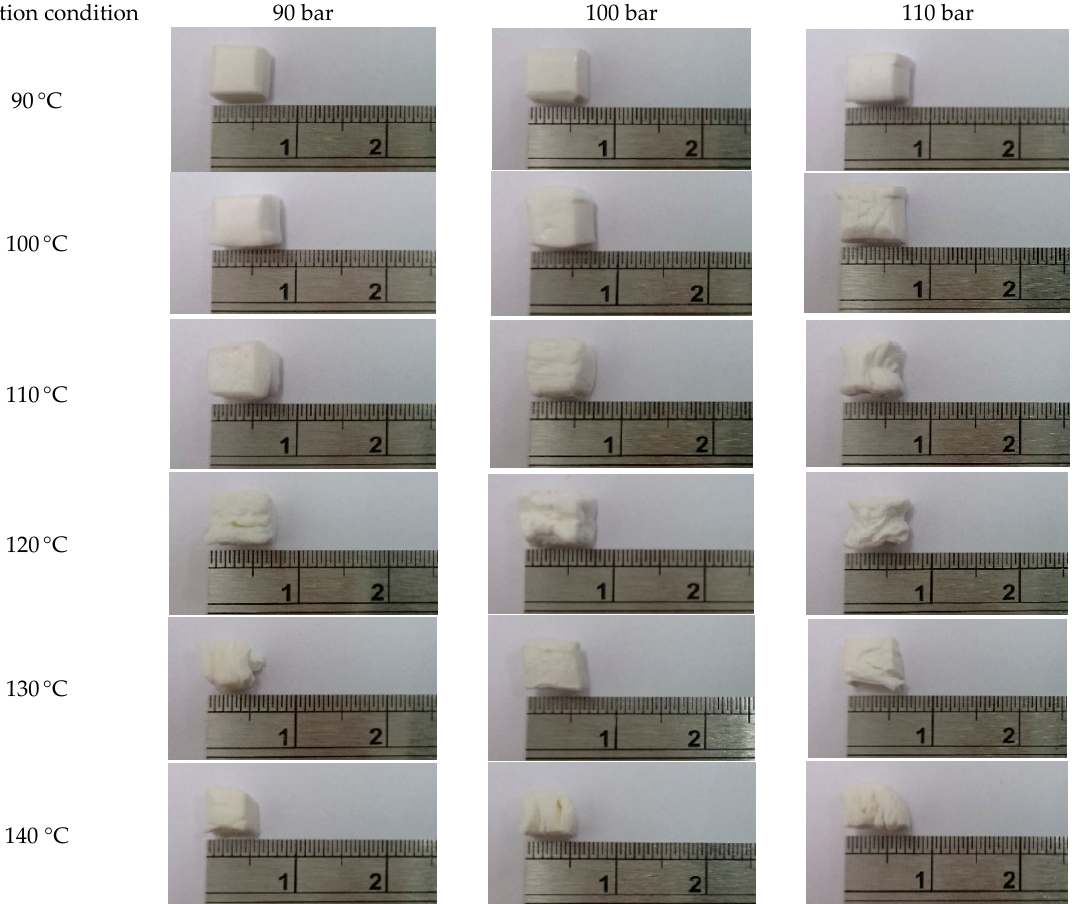
Figure 5. Comparison of surface morphology of TPU foams obtained from different saturation temperature and saturation pressure. Table 1. Operating parameter and results of supercritical CO 2 foaming of